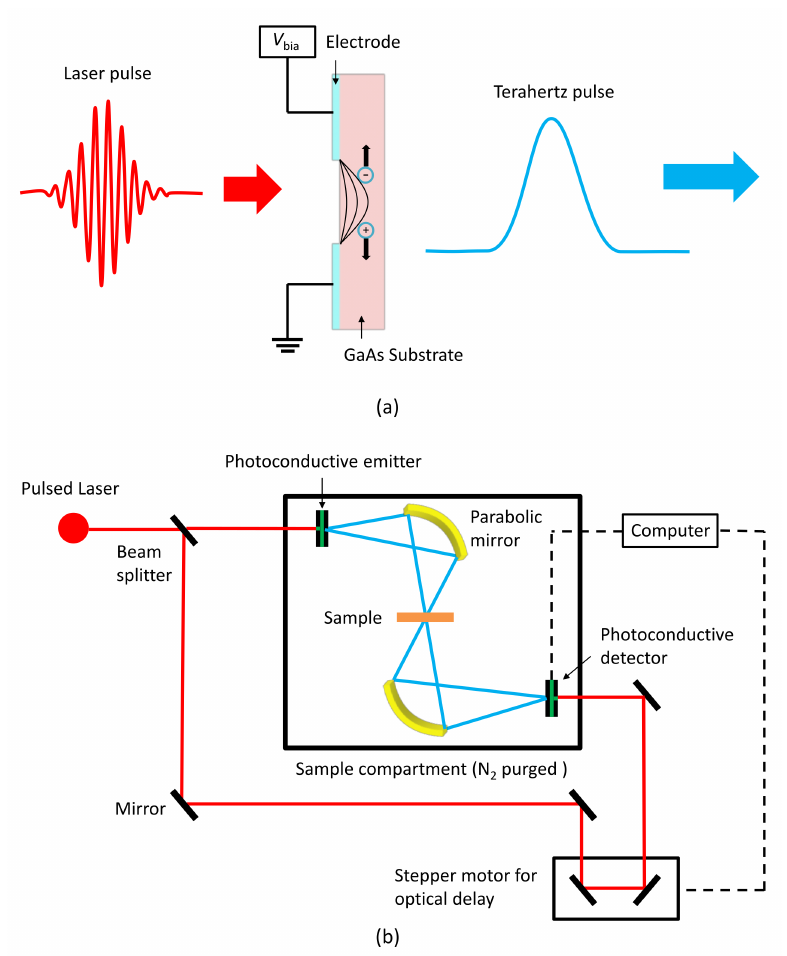
Figure 2. ( a ) Generation of terahertz pulse using femtosecond laser pulse. ( b ) Generation and detection mechanisms of terahertz radiation in terahertz